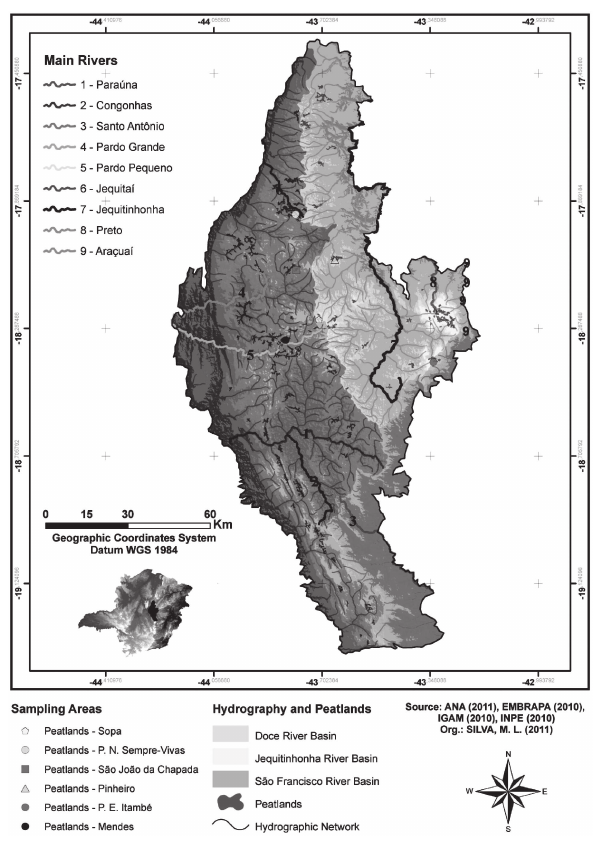
Figure 1. Location of peatlands in three major hydrographic basins of the study